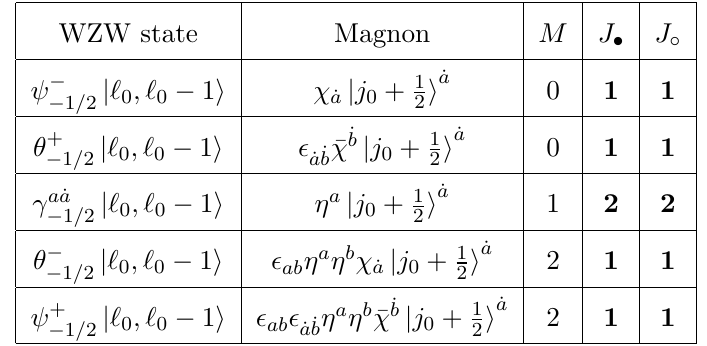
Table 5 . Level N e(cid:11) = 0 fermions in the chiral NS sector of the WZW model and their spin-chain counterparts. As described in appendix D, the sl (2) fermions are denoted by (cid:6) , the su (2) ones by (cid:18) (cid:6) , and the four free fermions (cid:13) a _ a are bi-spinors of su (2) (cid:15) (cid:8) su (2) (cid:14) . argument in terms of partition functions, it is instructive to explicitly match some low- lying states in the chiral sector, namely those with N = 0. Below we restrict to the e(cid:11) un(cid:13)owed chiral